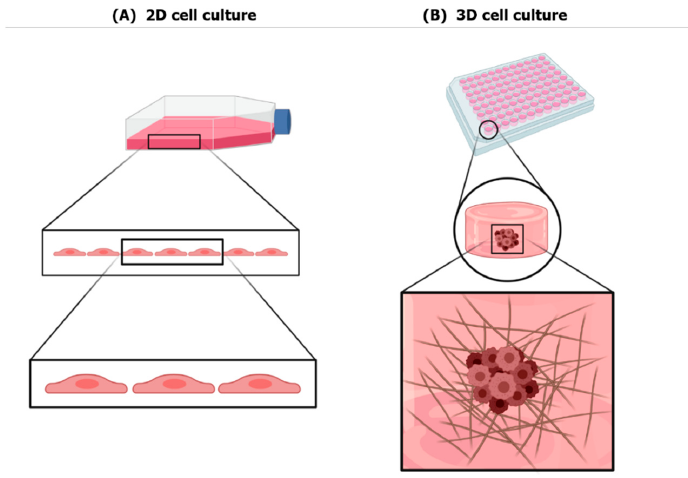
Figure 1. 2D vs. 3D cell culture: ( A ) Cell behavior in 2D conventional cell culture. Cells cultured in a 2D manner tend to have a flat shape that does not represent the real physiological cell